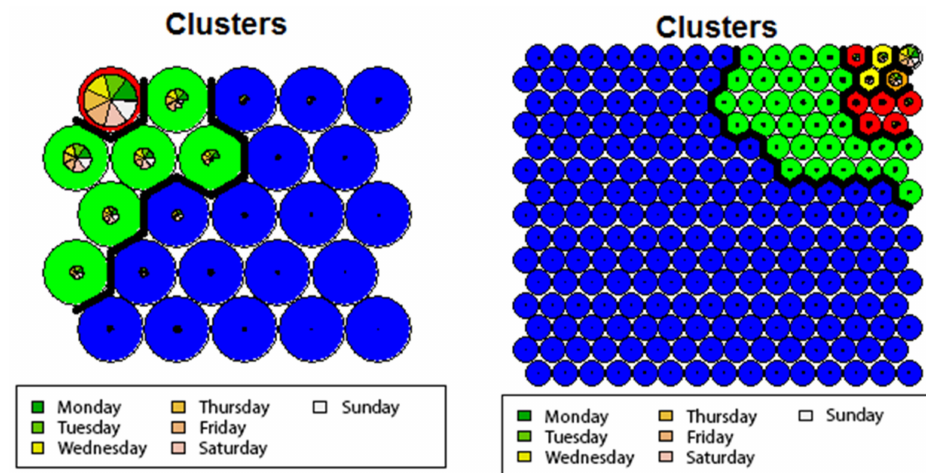
Figure 14. Gathering similar nodes into classes: cases 5 × 5 and 15 × 15).